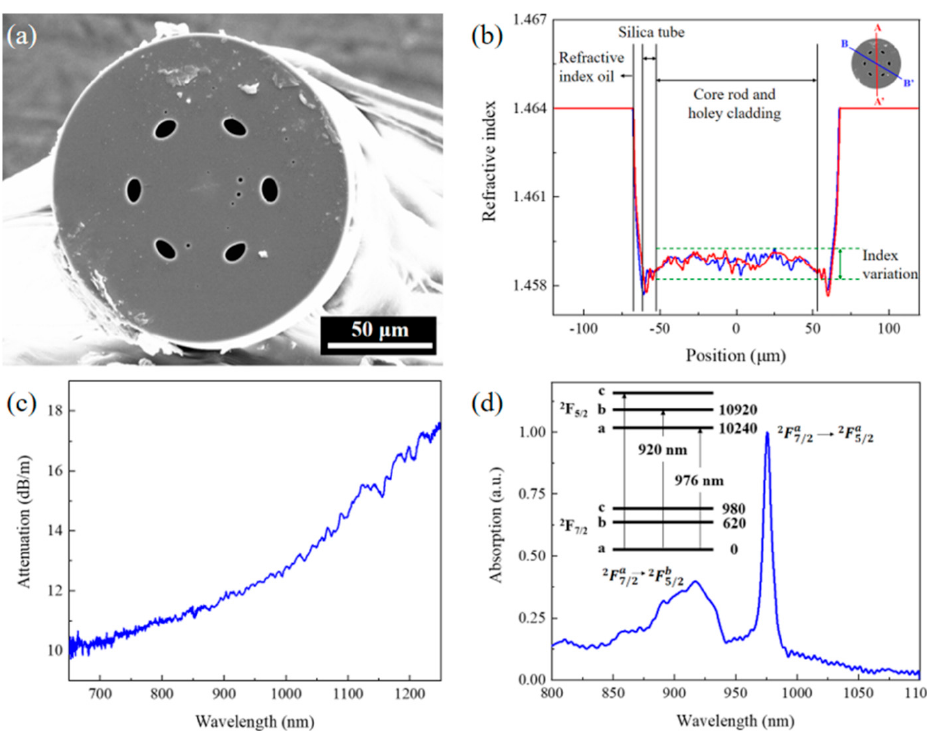
Figure 7. ( a ) SEM image of the Yb − doped silica microstructured optical fiber; ( b ) the refractive index profile of the fabricated Yb − doped silica microstructured optical fiber along different directions, ( c ) variation of attenuation of the fiber with different wavelengths, and ( d ) the absorption spectrum of the fiber [95].